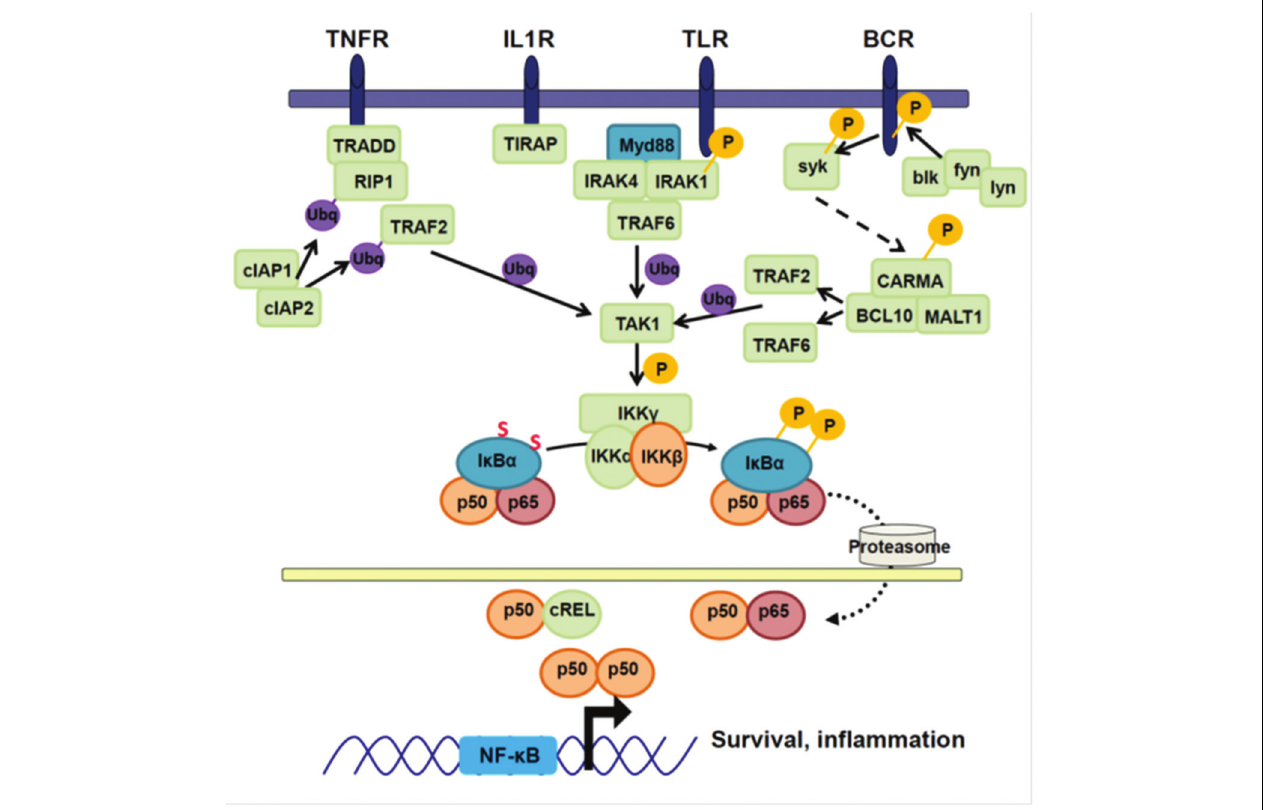
FIGURE 2 | Canonical NF- κ B signaling. Canonical NF- κ B signaling is activated by the binding of extracellular ligands. Each receptor family differs in the upstream signaling molecules used to mediate signaling, but they share activation of TRAF2 and TRAF6. The TRAFs ubiquitinate TAK1, causing TAK1 to be activated and associate with IKK γ . TAK1 can then phosphorylate IKK β , which in turn phosphorylates I κ B α . Phosphorylated I κ B α is degraded by the proteasome, releasing the canonical transcription factors p65, p50, and cREL. These translocate into the nucleus and activate pro-survival and pro-inflammatory genes.